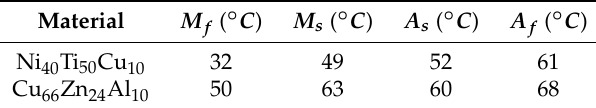
Table 1. Transformation temperatures of the SMA